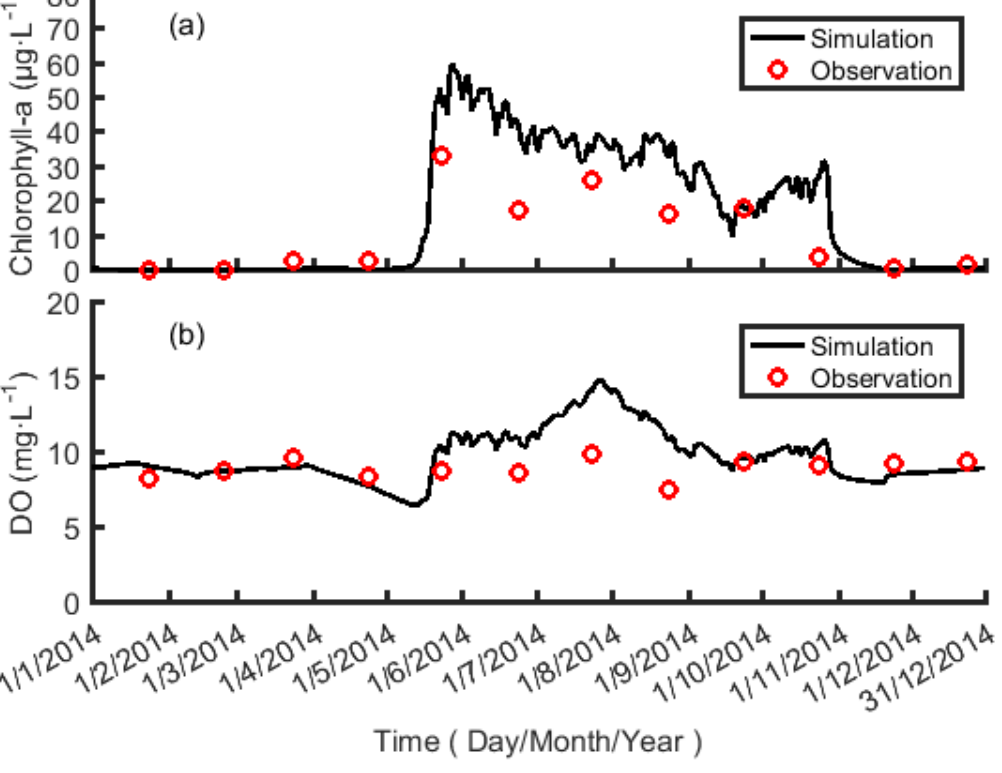
Figure 4. S ti profiles for Chlorophyll-a concentration and dissolved oxygen